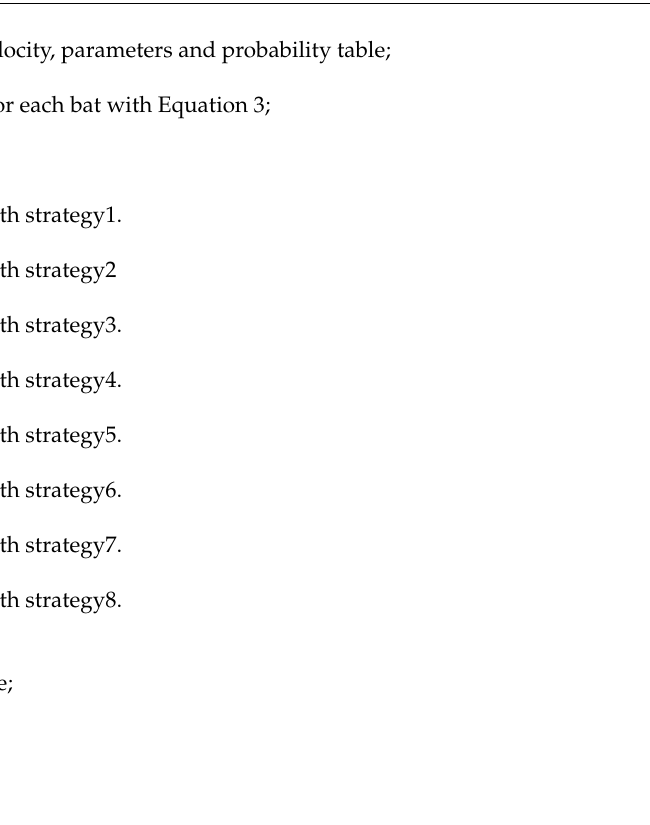
Table 1. The procedure of the bat algorithm (BA) with multiple strategy coupling. Algorithm 1: Bat algorithm with multiple strategy coupling